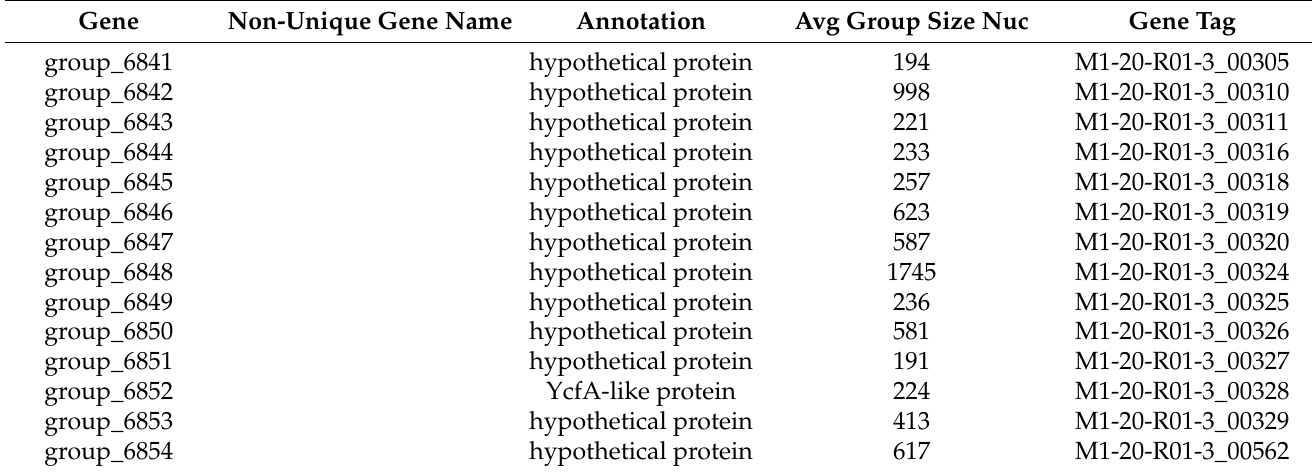
Table 5. Strain-specific genes identified by Roary for B. longum